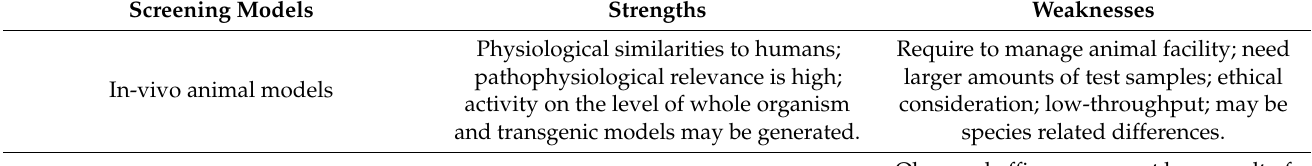
Table 3. Strengths and weaknesses of various biological screening models used for natural